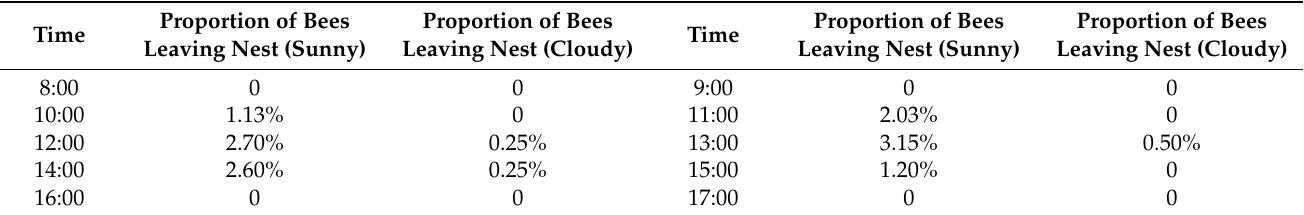
Table 3. The proportion of bees leaving the nest on different